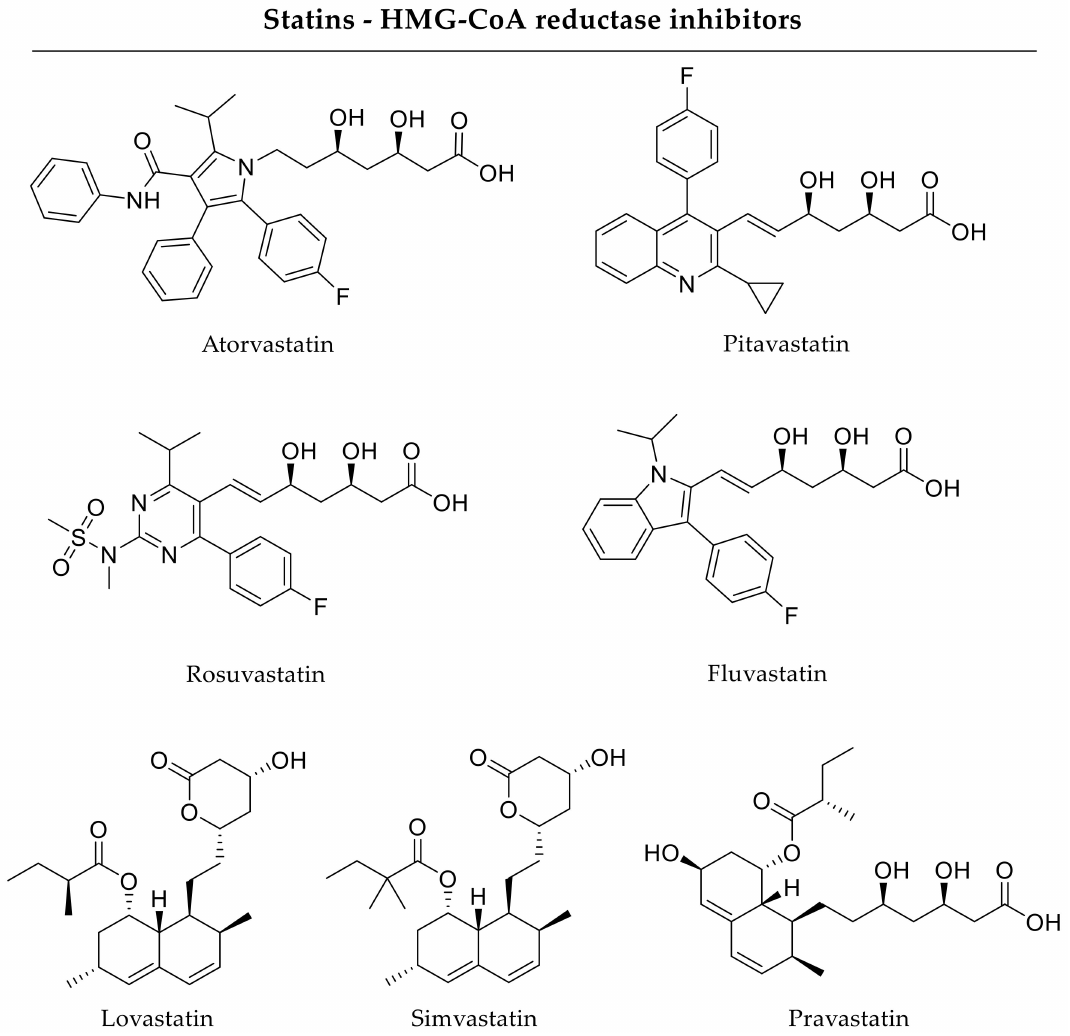
Figure 3. Chemical structures of selected HMG-CoA reductase inhibitors. The statins elicit pleiotropic e ff ects regarding bone regeneration, despite having di ff erent carbo- and heterocyclic core structures. Anabolic impacts rely on stimulation of osteogenesis, but the statins also evoke dose-dependent anti-inflammatory and pro-angiogenic e ff